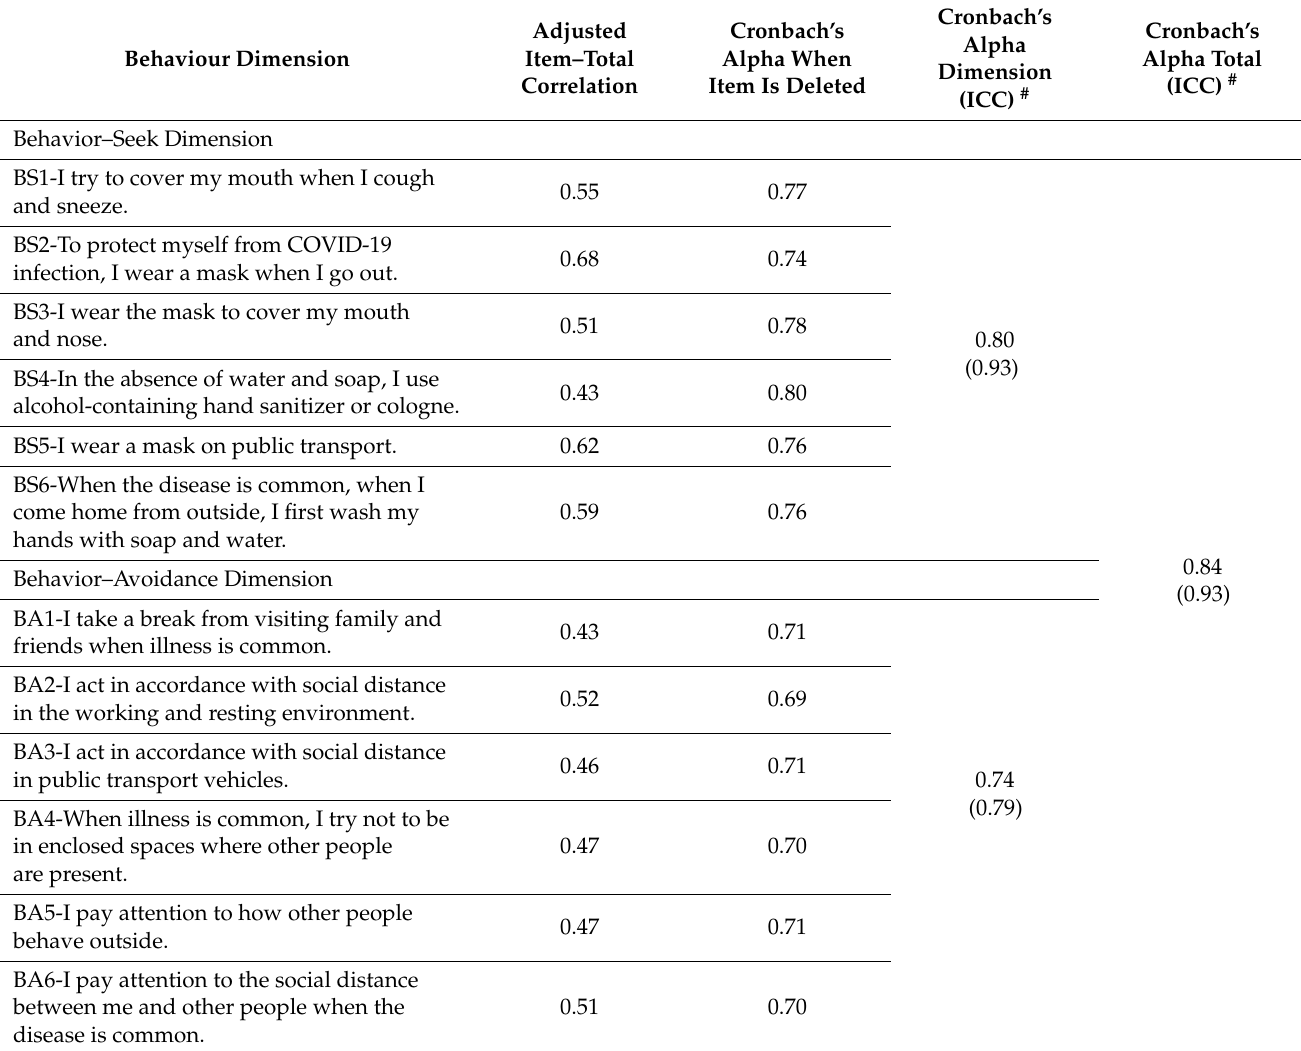
Table 3. Behavior dimension reliability